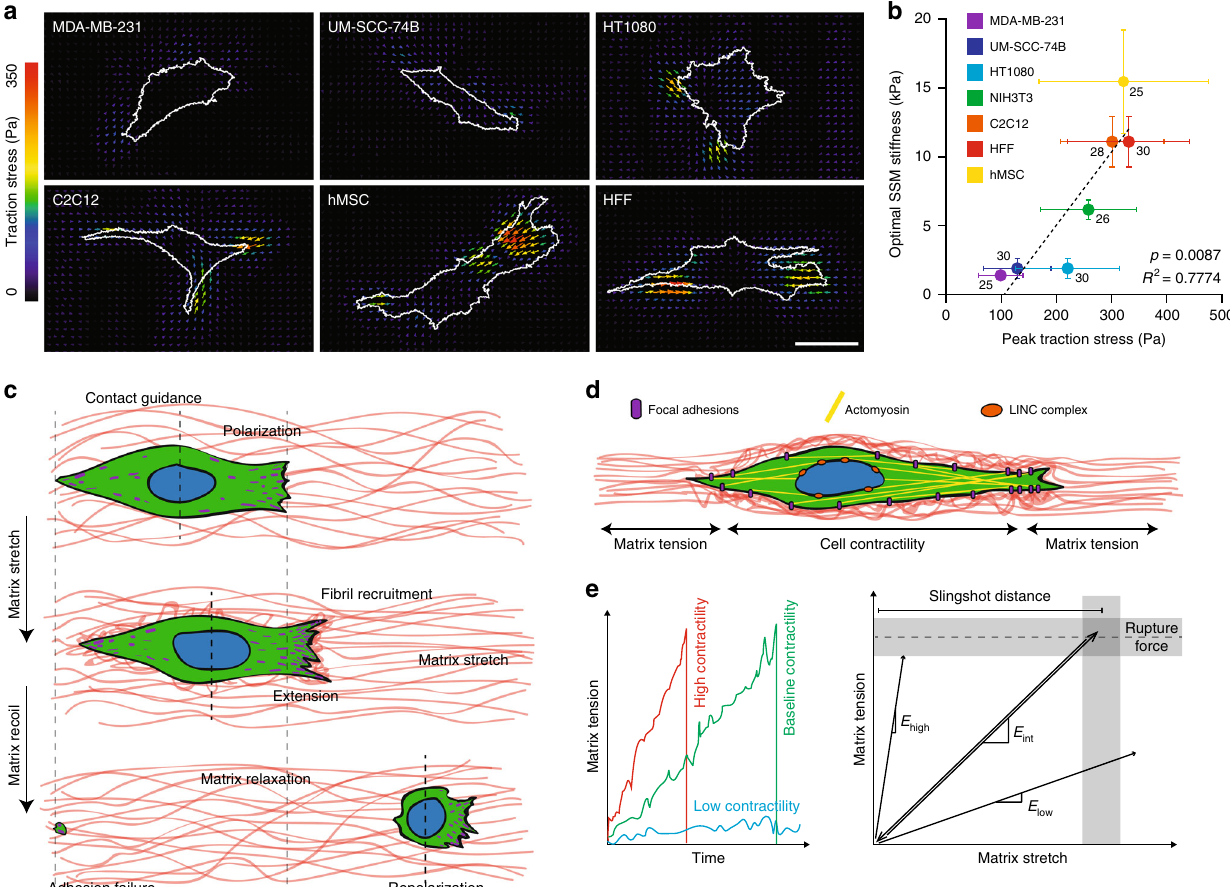
Fig. 6 Contractile cell types employ slingshot migration in a matrix stiffness-dependent manner. a Representative traction stress maps of MDA-MB-231 (breast adenocarcinoma), UM-SCC-74B (head and neck squamous cell carcinoma), HT1080 (connective tissue fi brosarcoma), C2C12 (mouse myoblast cell line), hMSC (primary adult mesenchymal stem cells), and HFF (primary human foreskin fi broblasts) on 7.9 kPa polyacrylamide hydrogels (scale bar: 50 μ m). b Matrix stiffness leading to maximal slingshot duration for each cell type as a function of peak traction stress for each cell type, as determined by traction force microscopy. n = number of cells per group as indicated beside each data point. Data presented as mean ± s.d. Dashed line indicates linear correlation with indicated R 2 and p -value (linear regression). c Top-down schematic depicting key steps underlying slingshot migration in aligned fi brous matrices, including contact guidance-mediated polarization (top), protrusion extension simultaneous with fi bril recruitment and matrix stretch (middle), and adhesion failure inducing rapid recoil and cell translocation (bottom). Theorized adhesion distributions are shown in purple. d Schematic highlighting force balance between cell-generated contractile forces and tension in the matrix. e Proposed time evolution of matrix tension as a function of cell contractility (left) and relationship between matrix tension and stretch at different levels of matrix stiffness (right). Note: these plots are